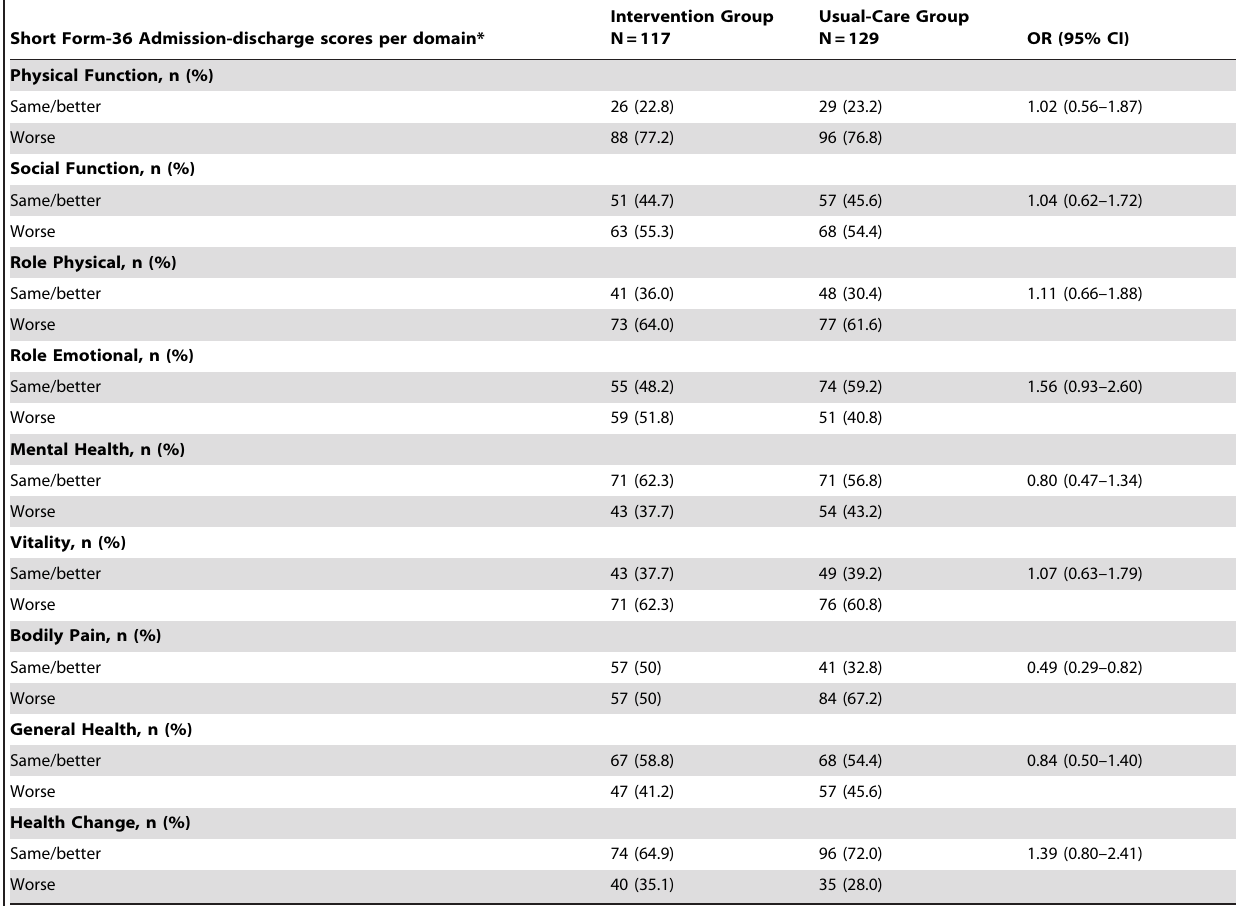
Table 5. Efficacy of intervention on quality of life.